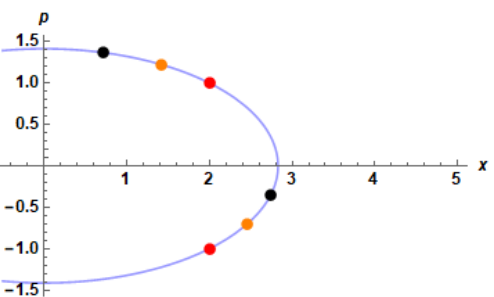
Figure 3. Family of optimal encoding schemes. For a given value of the parameters a and b (here, a = 2 and b = 1), each optimal encoding consists of preparing two coherent states (see two black points, two yellow points, two red points, etc.) according to Equation